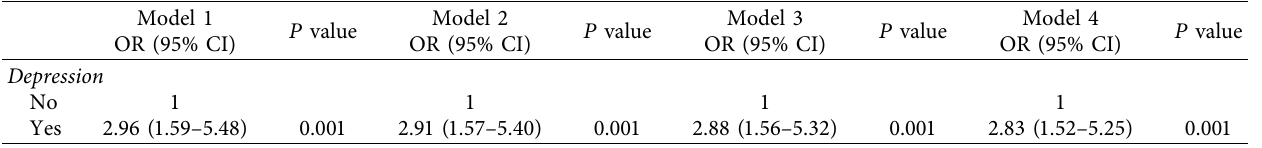
Table 3: Adjusted models for association of depression with uncontrolled hypertension ( N � 1856).